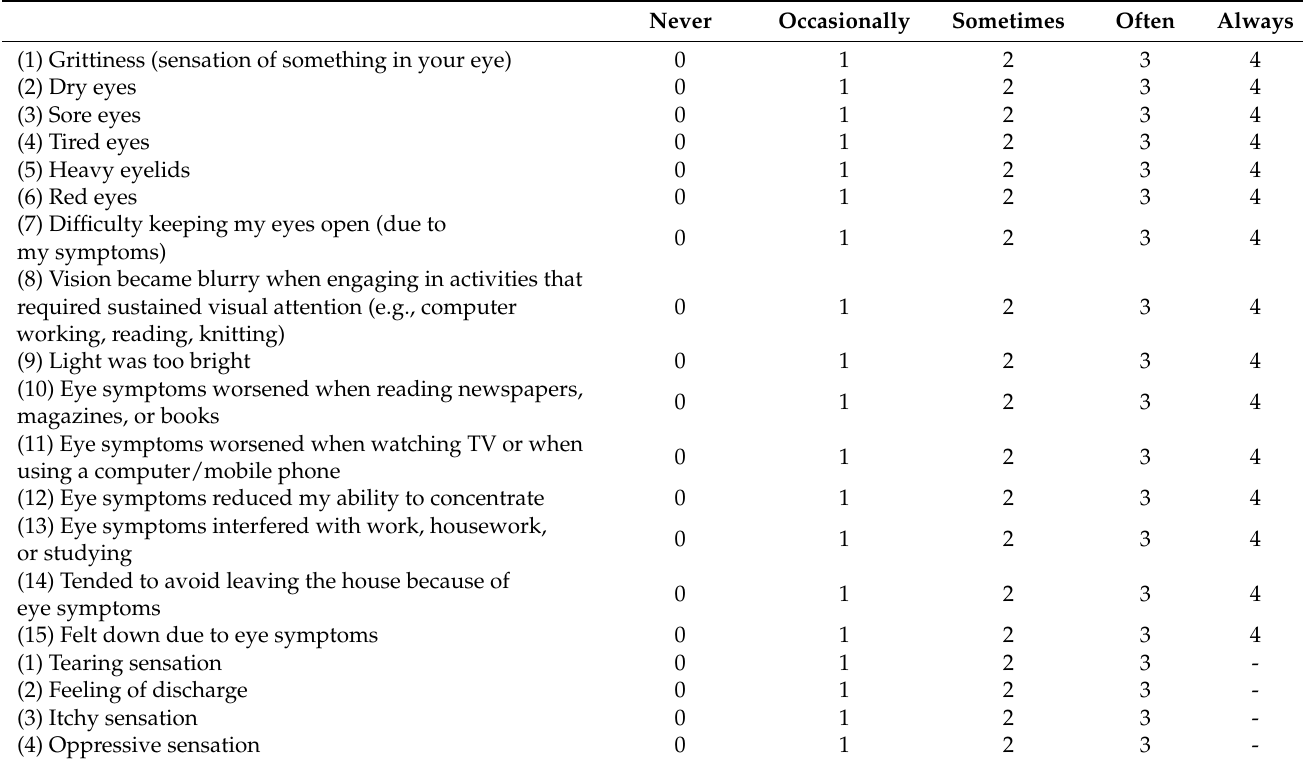
Table 1. Dry Eye–Related Quality-of-Life Score (DEQS) questionnaire and an additional four symp- tom items about which subjects were